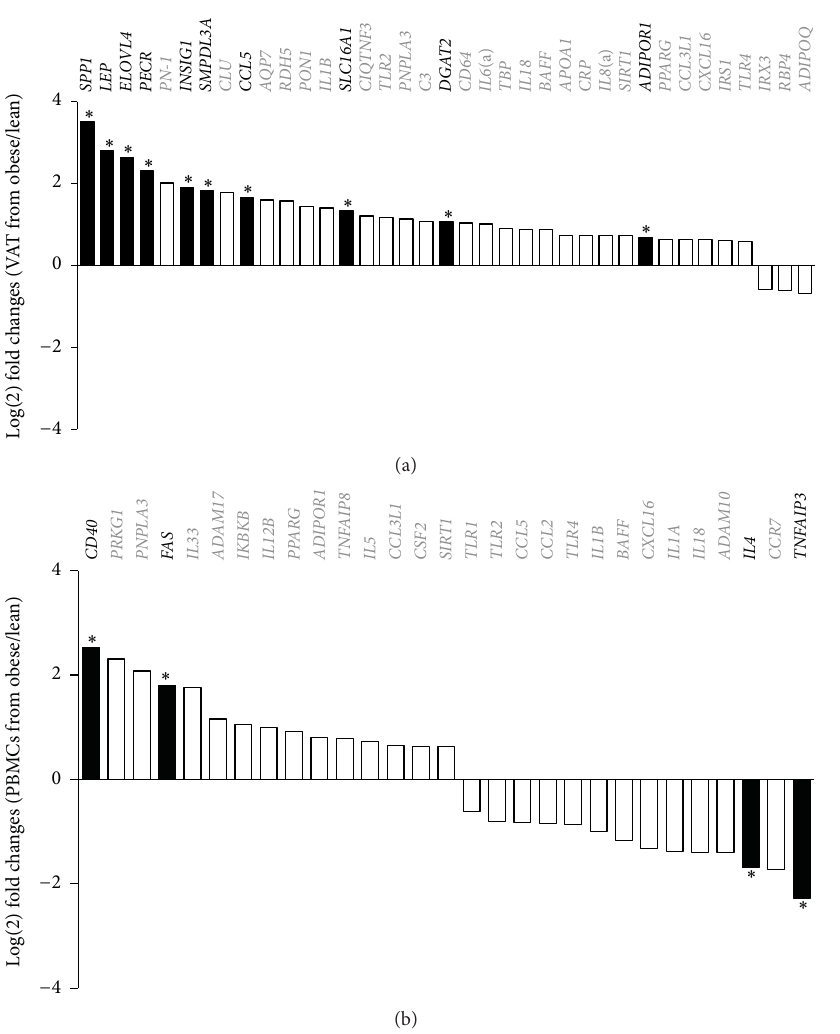
Figure 3: Expression profile of the genes that showed a log (2) fold change ratio higher than 1.5. The log (2) difference between lean and obese pigs in the retroperitoneal adipose tissue (a) and the PBMCs (b). +log (2) FC: upregulated in obese pigs; − log (2) FC: downregulated in obese pigs. Gene names and columns in black: significant differential expression. ∗ 𝑝 < 0.05